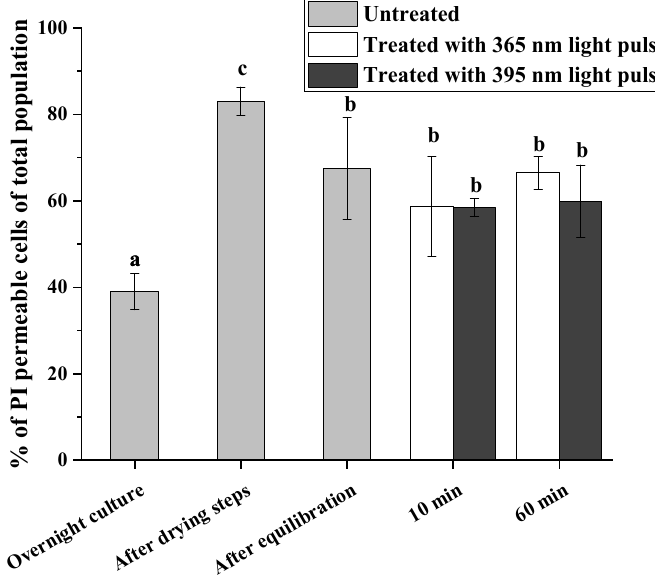
Figure 2. Effect of vacuum drying and equilibration to 0.75 a w and 365 and 395 nm LED treatments on the cell membrane of the S. Typhimurium ATCC13311 cells by PI (propidium iodide) exclusion assay. Here the Y-axis in the graph represents the percentage of PI-permeable cells of the total population when analyzed using a flow cytometer. Treatments with the 365 and 395 nm light pulses of low-a w S. Typhimurium cells were performed for 10 and 60 min, corresponding to treatment doses of 28.9 and 188.1 J/cm 2 for 365 nm and 138.8 and 834.4 J/cm 2 for 395 nm, respectively, at 60% power level and at 4 cm from the LED heads. Results are represented as means ± standard deviation of three independent replicates. Values with different letters differ significantly ( p <